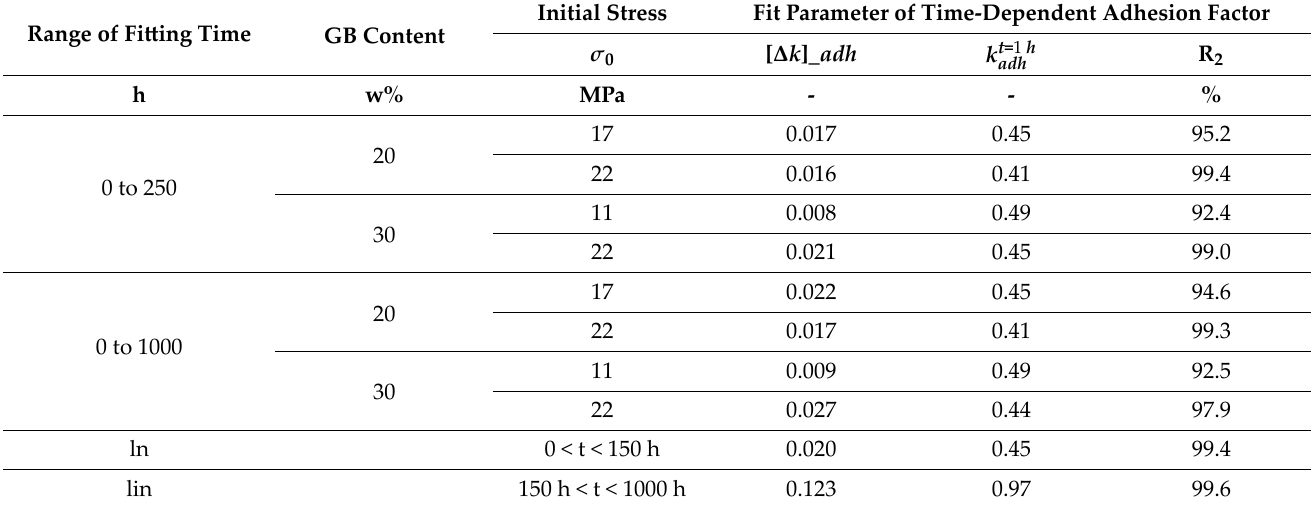
Table 4. Fit parameters k t = 1 h and ∆ k adh of time‑dependent adhesion factors for fitting times ranging adh from 0 to 250 h and 0 to 1000 h. R 2 shows the correlation coefficient of measured and fitted curves.